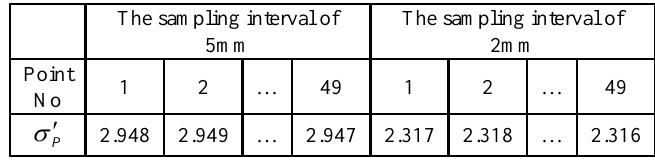
Table 2. The actual point error